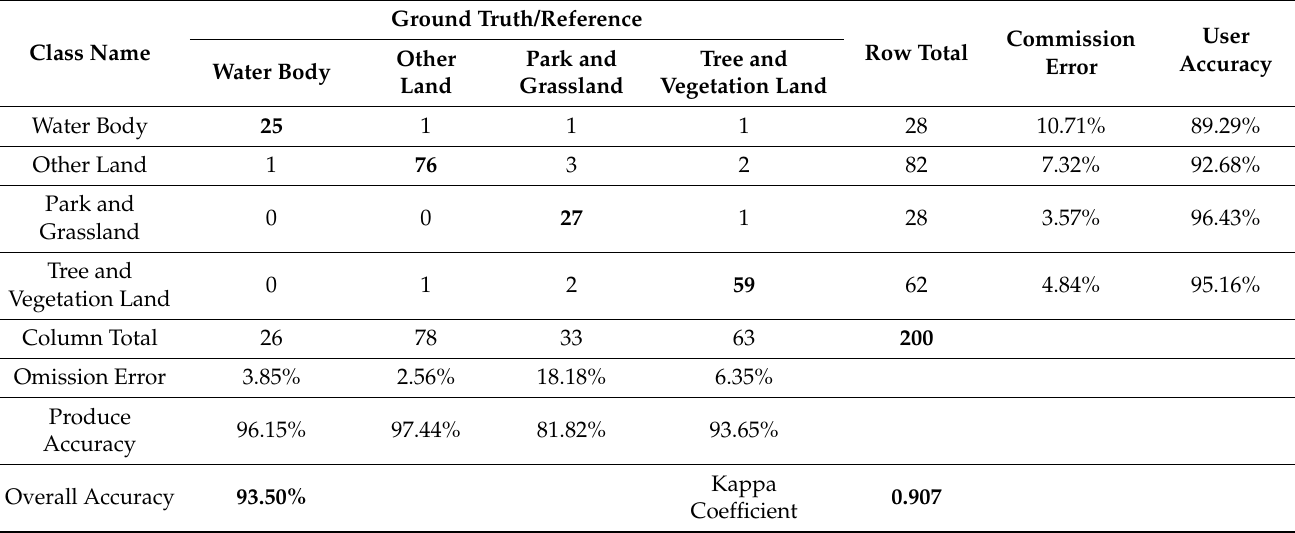
Table 6. Accuracy assessment and kappa coefficients for the year of